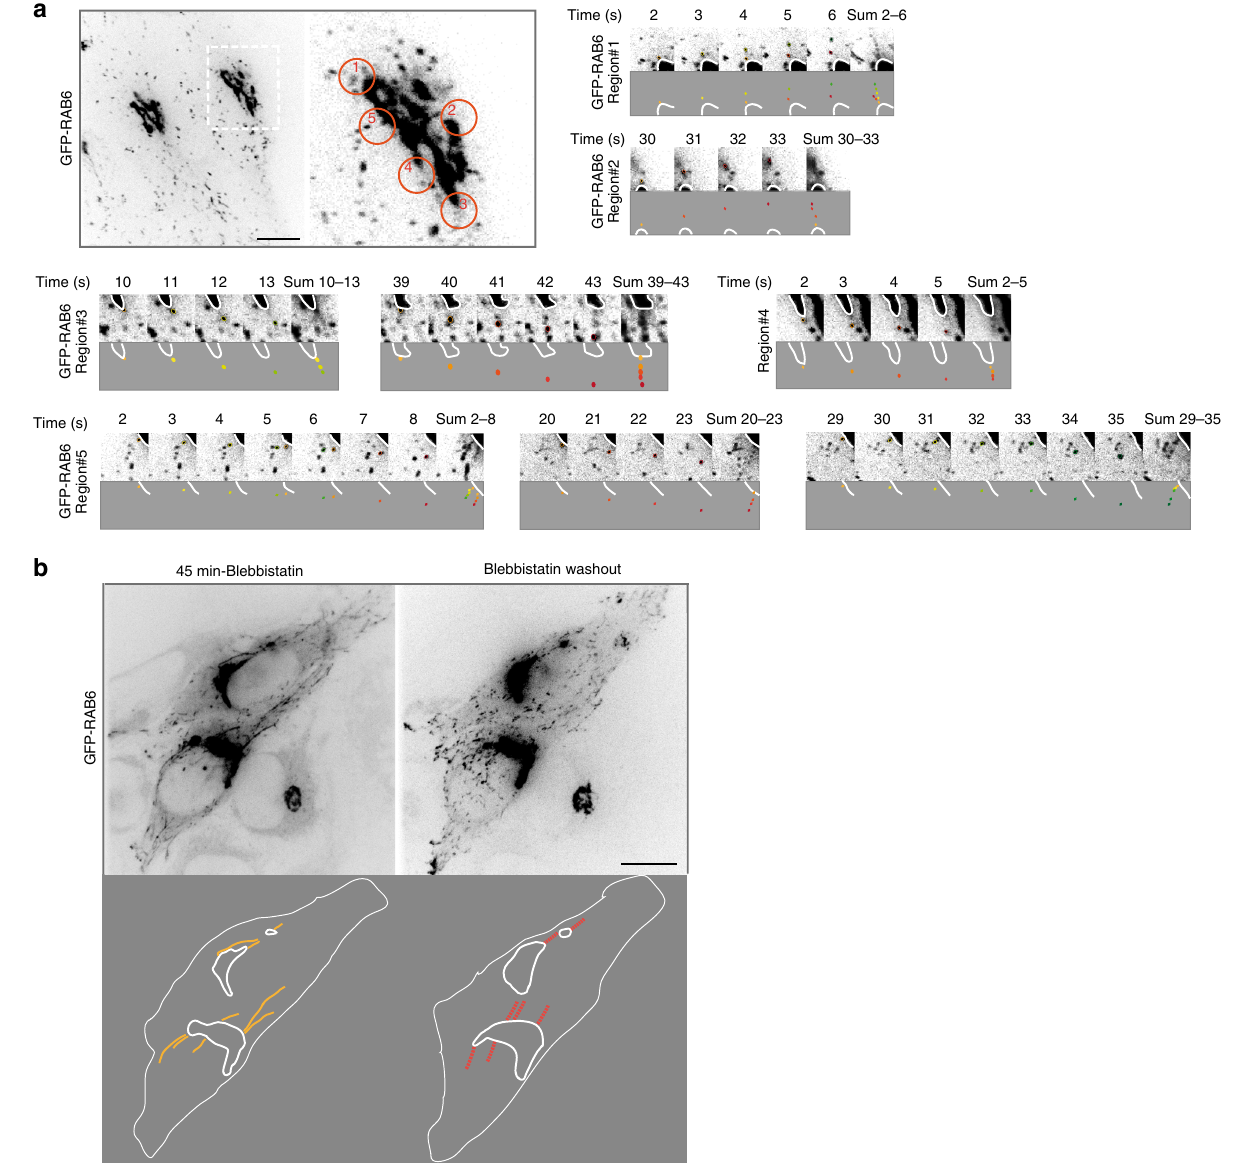
Fig. 1 GFP-RAB6-positive vesicles exit the Golgi at fi ssion hotspots. a HeLa cells stably expressing GFP-RAB6 were imaged every second for 1 min (Supplementary Movie 1). Orange circles show the location of fi ve fi ssion hotspots. Details of each fi ssion event for the fi ve regions of hotspots are displayed. In each case, sequences of images are displayed at the top and a scheme of the events at the bottom. The Golgi region is highlighted by a white line. Vesicles exiting the Golgi are drawn and painted either yellow-green or orange-red. A sum of the events is shown at the end of each sequence. b Cells were treated for 45 min with para-nitro-blebbistatin. Then, para-nitro-blebbistatin was washed out. After recovery of normal GFP-RAB6 vesicles traf fi cking, the cells were imaged every second for 60 s (Supplementary Movie 3). A scheme of the images is displayed at the bottom. The Golgi regions are highlighted by a white line. Tubes are drawn in yellow. Regions where the GFP-RAB6-positive fi ssion hotspots are found are drawn in red. Bars: 10 µ